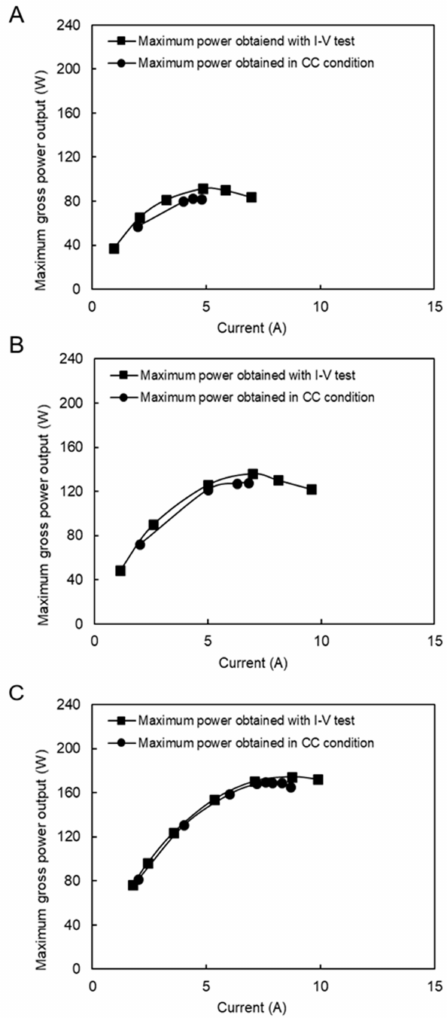
Figure 12. Constant current and I–V measurement with model SW and RW feed solutions ( A ) SW/RW; 8/10 (L/min), ( B ) SW/RW; 13/20 (L/min), ( C ) SW/RW; 21/32